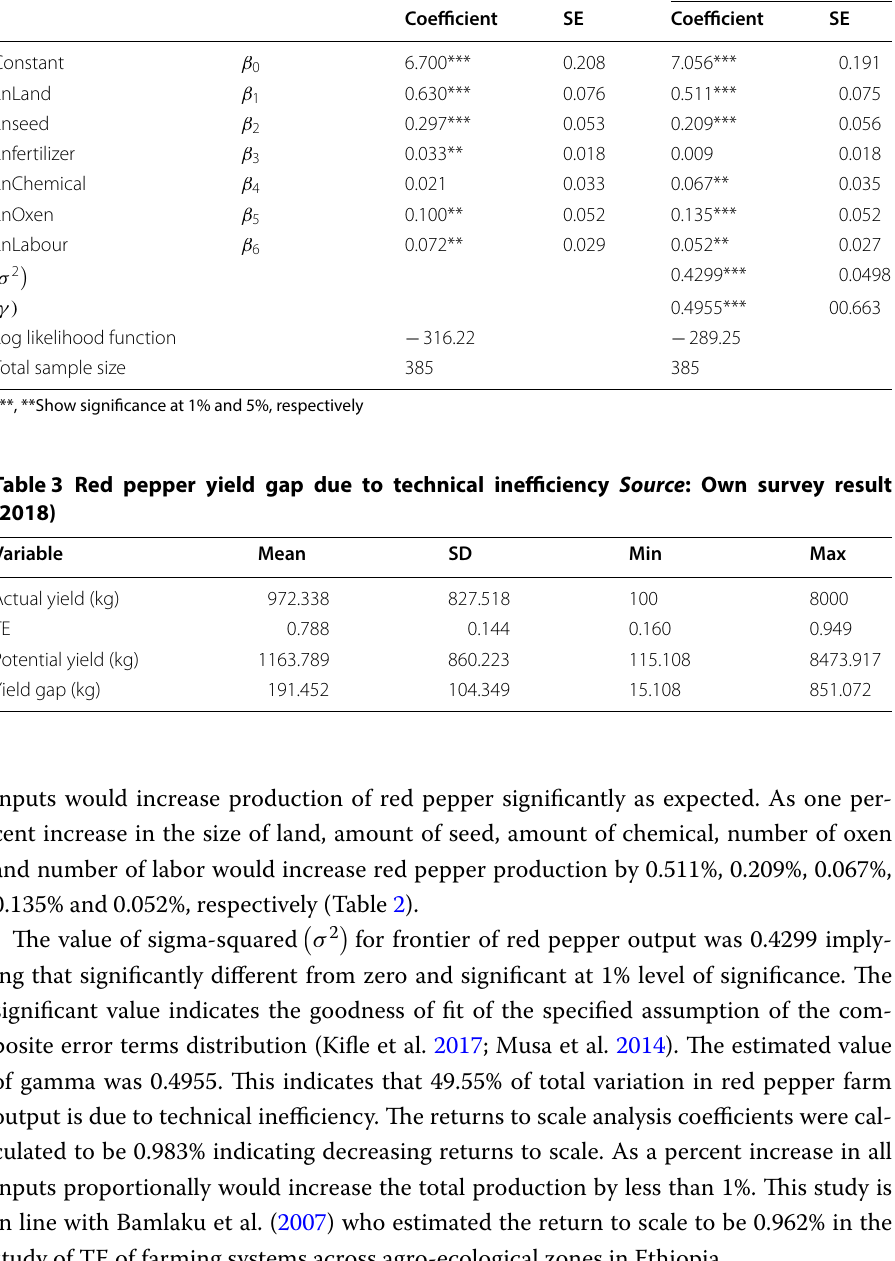
Table 2 Ordinary least squares (OLS) estimates of the average production function and maximum likelihood (ML) estimate of stochastic production frontier for red pepper farmers Source : Model output (2018) Variables